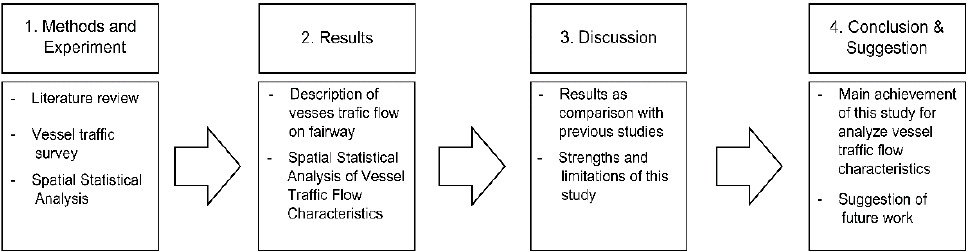
Figure 1. Outline of the research on traffic flow.